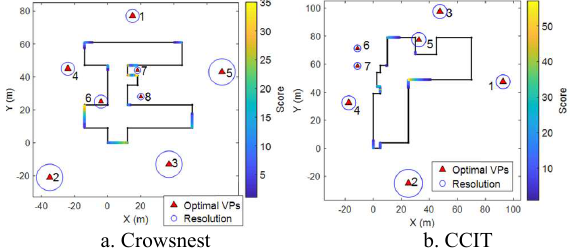
Figure 11. Invisible segments of 100 random